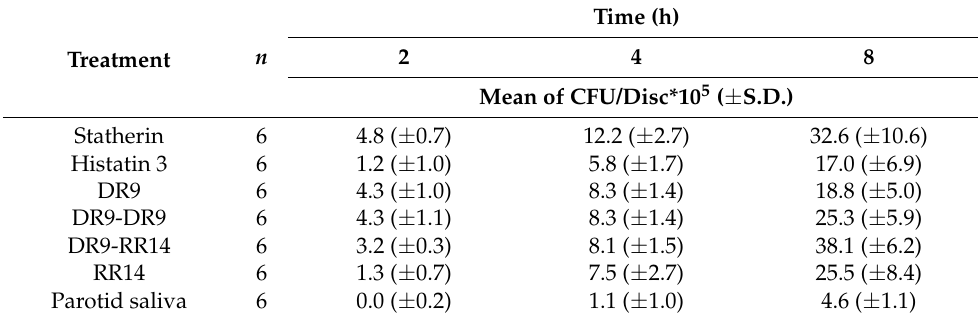
Table 2. Colony-forming units (CFU/disc*10 5 ) of S. mutans adhered to hydroxyapatite (HAp) according to the treatments and at each time point